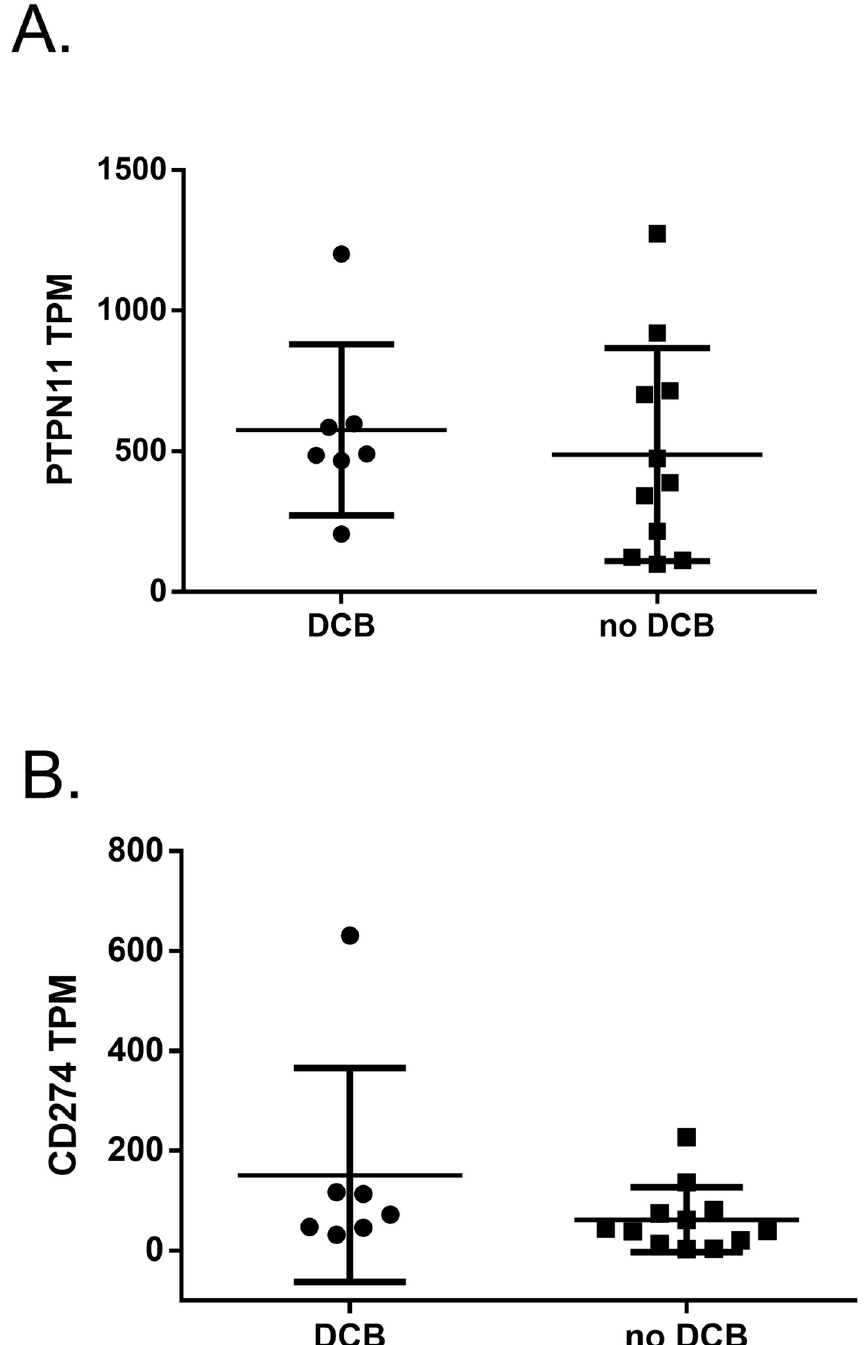
Fig 3. CD274, but not PTPN11, mRNA expression is associated with response to ICI in NSCLC tumors. A . PTPN11 TPM values for patients who did or did not demonstrate a durable clinical benefit (DCB) from ICI therapy, as determined by RECIST criteria [14]. There was no significant difference between groups, as measured by a student’s t- test. B . TPM values for CD274 in patients who did or did not demonstrate a durable clinical benefit (DCB) from ICI therapy, as determined by RECIST criteria. There was no significant difference between groups, as measured by a student’s t-test.